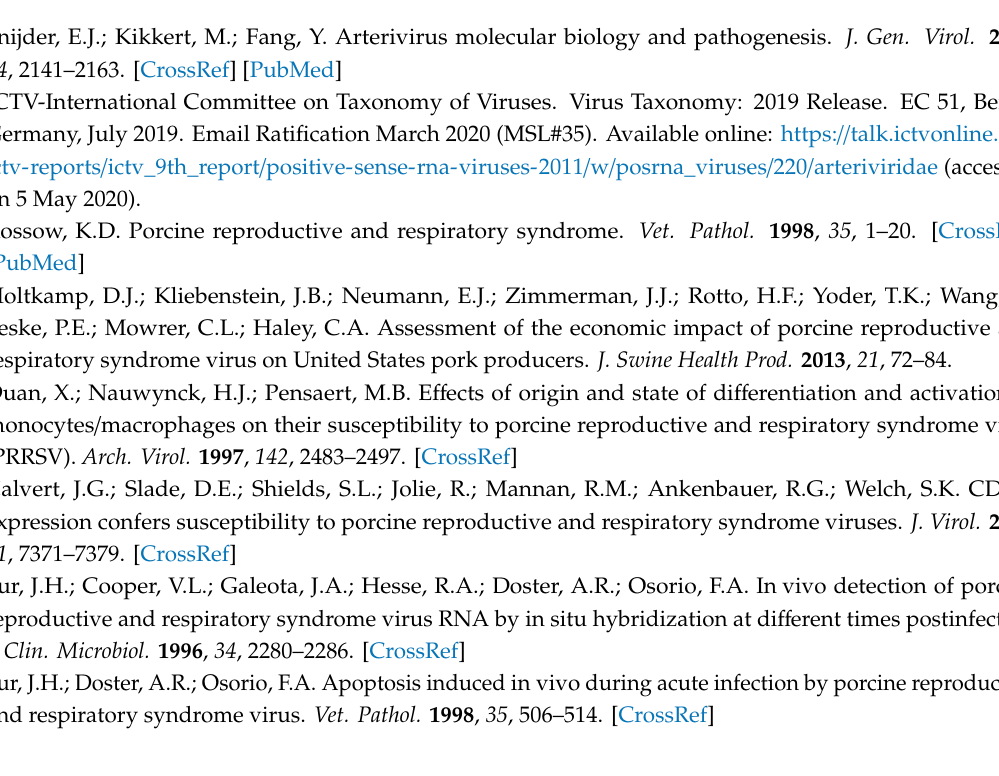
Figure S1. Representative flow cytometry gating strategy used to identify IFN- γ secreting CD4 α + , CD8 α + , and CD4 α + CD8 α + (DP) T cells from PBMCs and ILN. Table S1. Summary of sequencing quality control and mapping data of samples. Table S2. DEGs identified in group DMEM vs. CON90. Table S3. Detail information of GO enrichment of DEGs in DMEM vs. CON9. Table S4 Detail information of KEGG pathway enrichment of DEGs in DMEM vs.